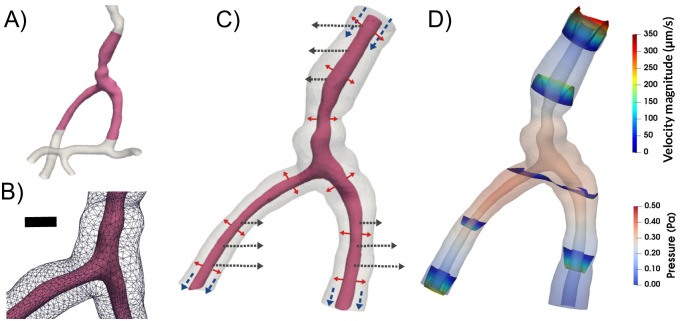
To study the mechanisms behind perivascular fluid flow, we extracted an image-based bifurcating arterial geometry (A) and generated a computational model of a surrounding perivascular space (B) subjected to different forces: arterial wall deformations (red arrows), systemic pressure variations (blue arrows) and rigid motions (black arrows) (C) to predict the induced CSF flow and pressure (D). Scale bar: 0.05 mm.